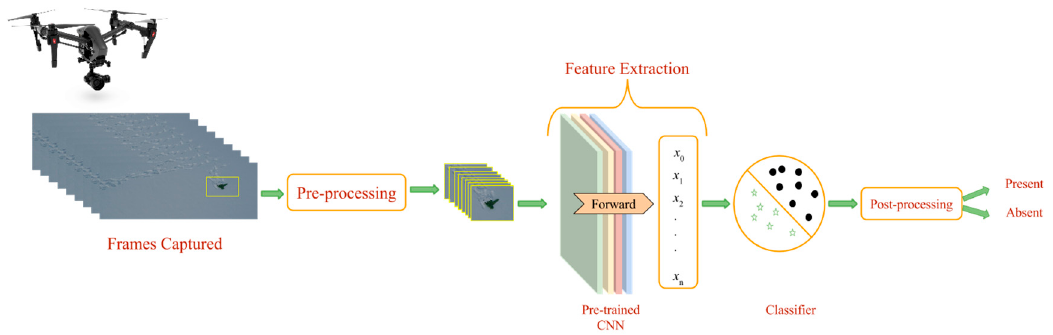
Figure 1. Block diagram of the overall system.